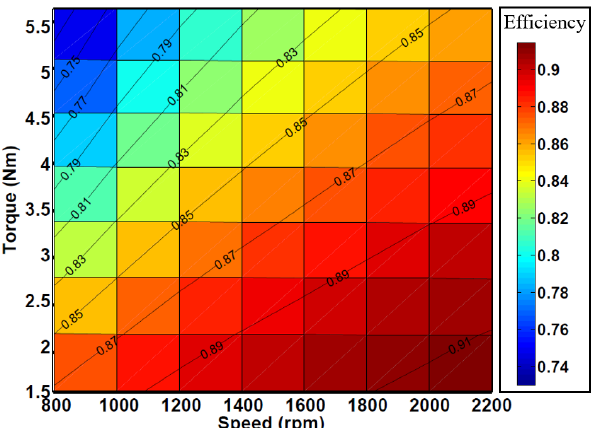
Figure 14. Change in motor efficiency under different working conditions.